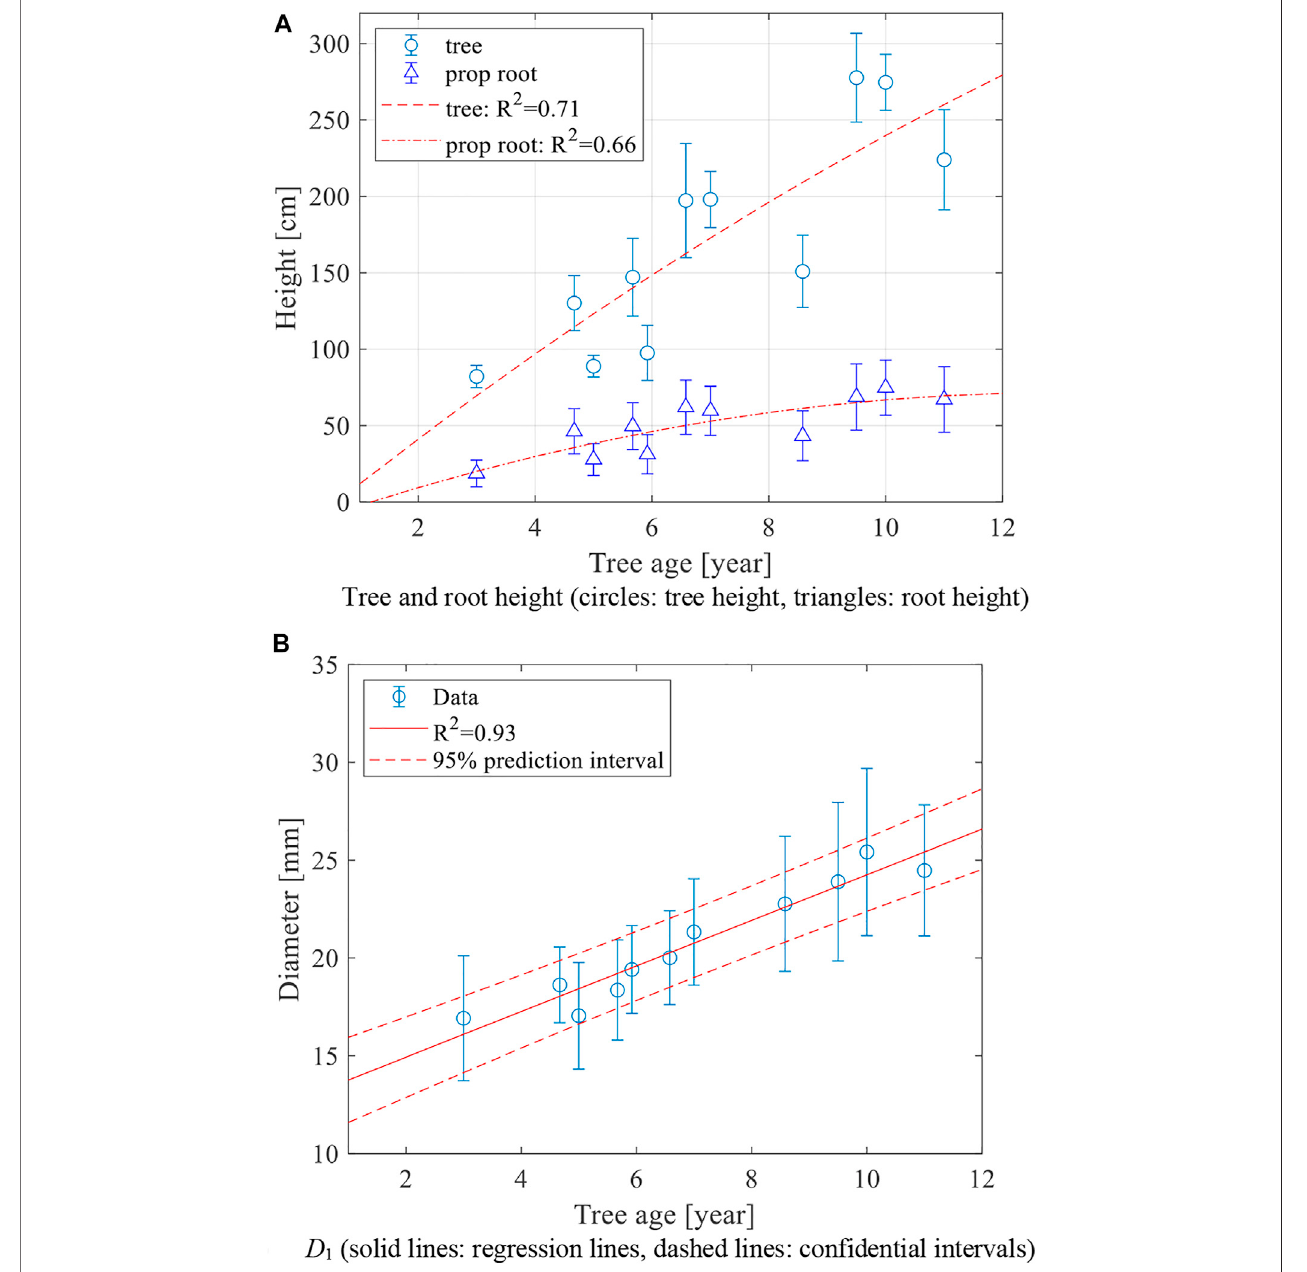
FIGURE 6 | Growth curves of diameter D 1 and tree height H vs. tree age by Kiribati data ( Rhizophora stylosa ).